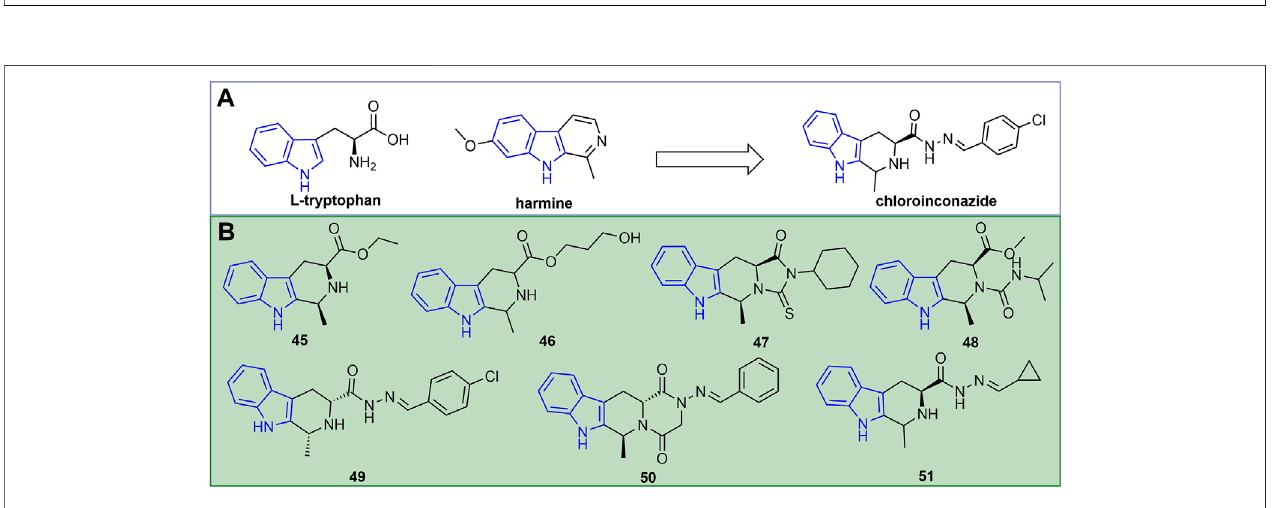
FIGURE 11 | Discovery of a novel antiviral agent chloroinconazide (A) . Structures of representative indole derivatives in antiviral activities (B) .